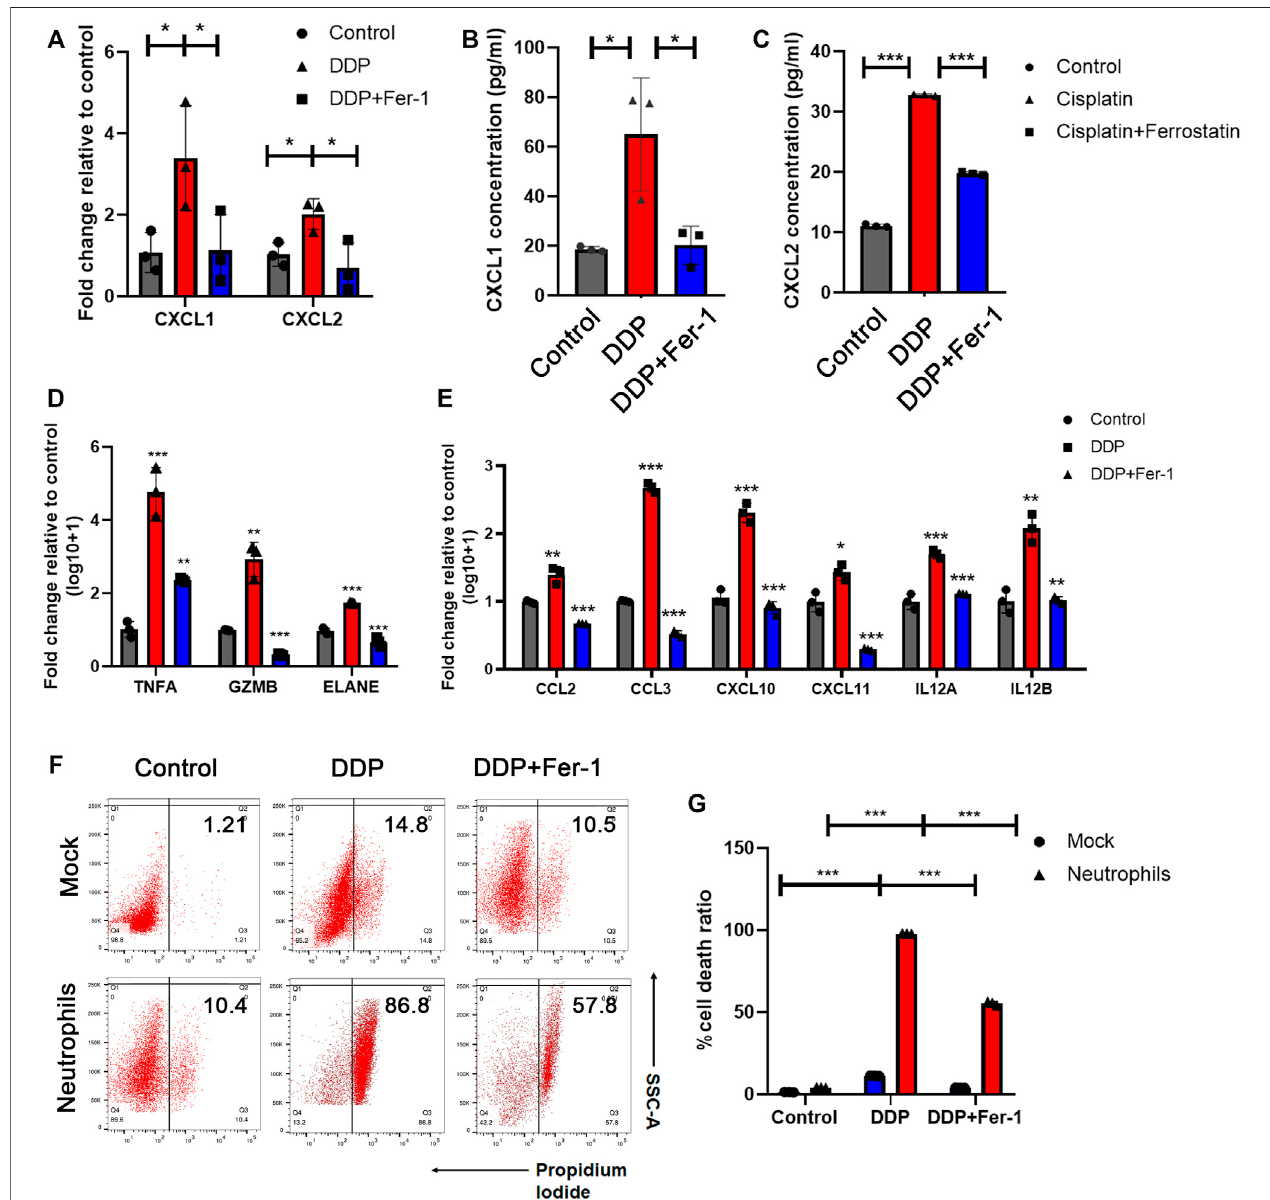
FIGURE 3 | N1-polarized neutrophils induced by cisplatin-mediated tumor ferroptosis exerted an anti-tumor effect. (A) Relative mRNA expression of CXCL1 and CXCL2 was tested by RT-qPCR assay in A549 cells treated with 5 μ M DDP or rescued by 10 μ M ferrostatin-1. (B) and (C) Concentration of CXCL1 (B) and CXCL2 (C) released by A549 cells in culture medium, which was tested by ELISA assay. A549 cell were treated with 5 μ M DDP or rescued by 10 μ M ferrostatin-1. (D) and (E) Relative mRNA expression of neutrophil cytotoxic markers (D) and pro-in fl ammatory markers (E) were tested by RT-qPCR assays in neutrophils co-cultured with A549 cells, which were pretreated with 5 μ M DDP or rescued by ferrostatin-1. (F) Cell death ratio of A549 cells treated with DDP or rescued by ferrostatin-1 before and after being co-cultured with neutrophils. (G) Quanti fi cation of data in (F) . DDP pretreatment remarkably increases the cytotoxic effect of neutrophils which would be rescued by ferrostatin-1. Bar graphs represent the mean ± SD of indicated samples. p p < 0.05, pp p < 0.01, ppp p < 0.001.